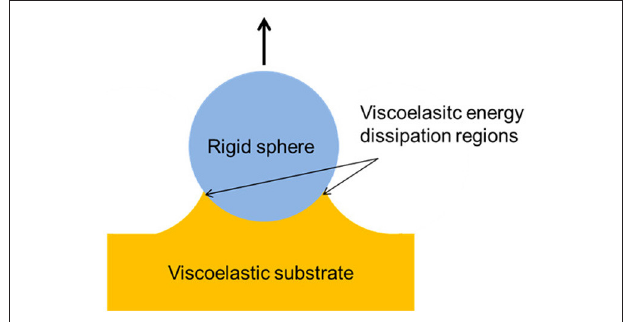
FIGURE 1 | The problem under investigation: a rigid sphere is pulled apart from a viscoelastic